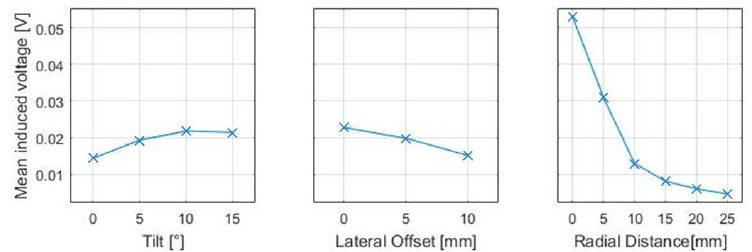
Figure 4. Main effect diagrams of relative positions for PCB based coils.